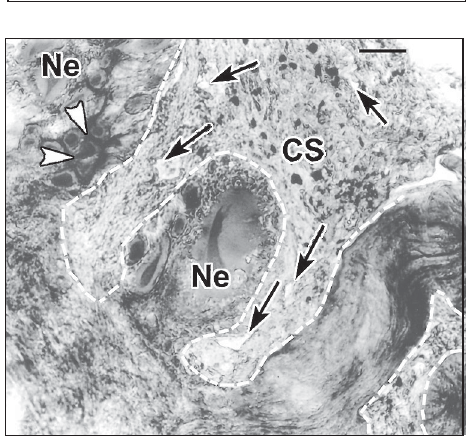
Figure 3. Photomicrograph of the interface region (discontinu- ous line) between the nervous tissue and the connective sheath (CS). Note the intense alkaline phosphatase activity through the nervous tissue (ar- rowheads). Observe the imbri- cate relationship between the nervous tissue and the connec- tive sheath where the negative hemolymph vessels (arrows) are housed. Ne, neurons. Bar = 100